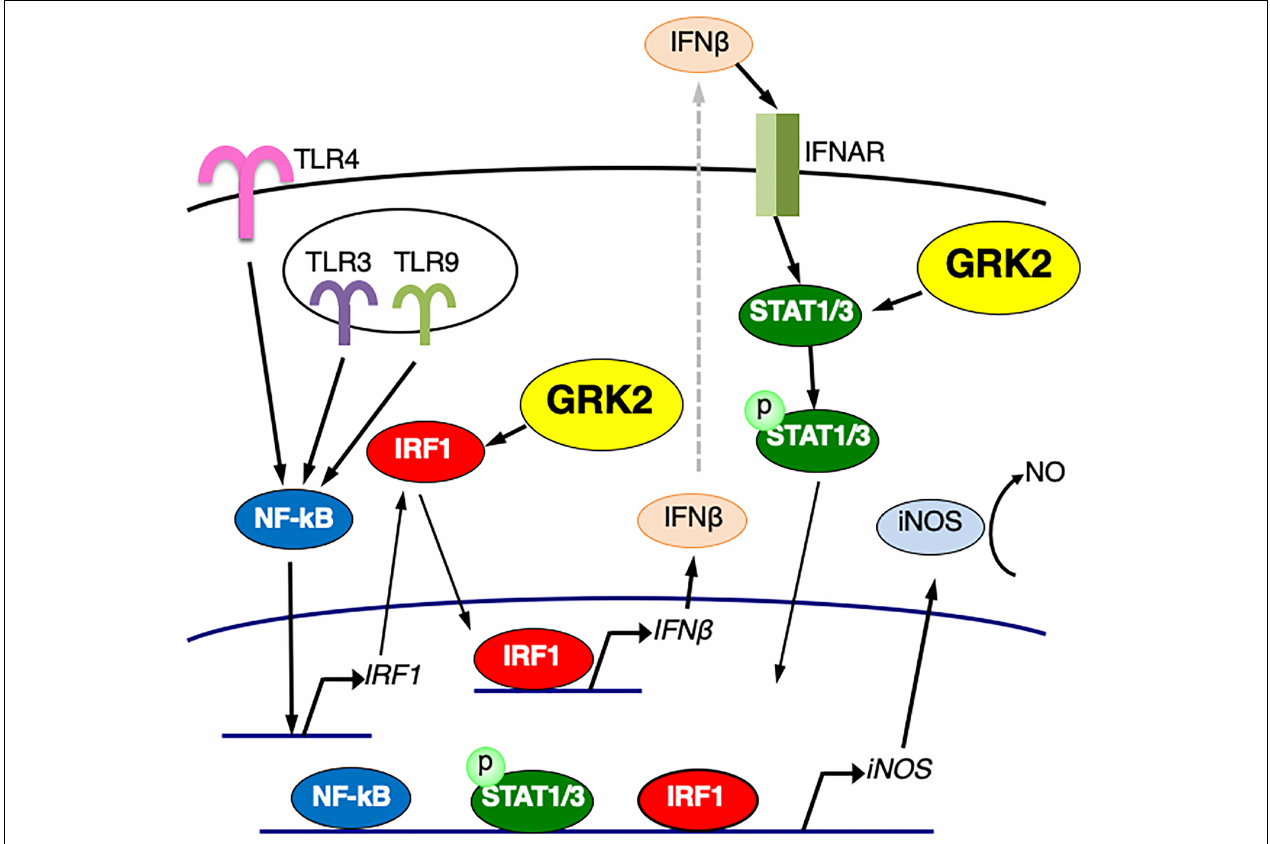
FIGURE 11 | Schematic diagram of the regulatory role of GRK2 in TLRs-mediated signaling pathways for iNOS expression in microglial cells. GRK2 positively regulates not only the expression/activation of IRF1 but the activation of STAT1/3, leading to the induction of iNOS transcription. See text for